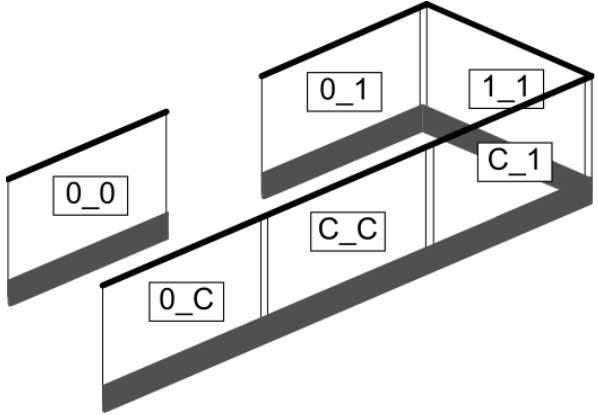
Fig. 3 Distinction of the different support condition situations for a balustrade